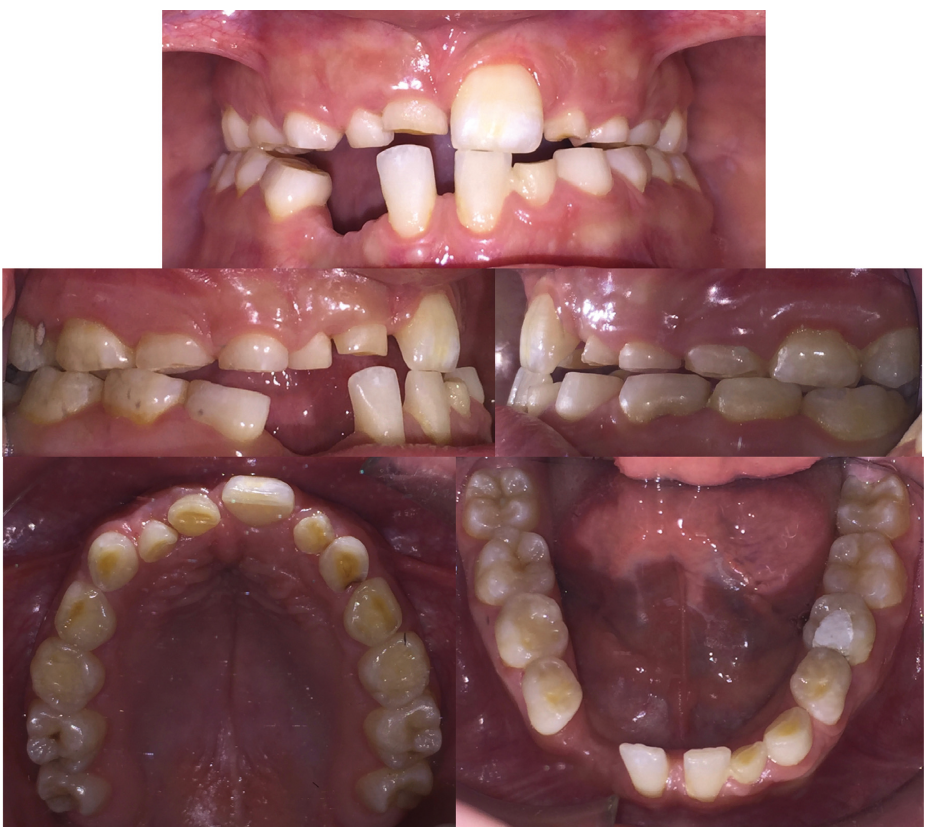
Figure 10: Case 1: intraoral